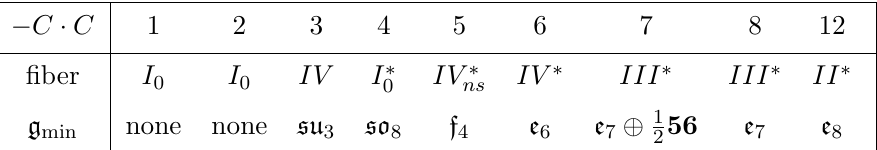
Table 1 . Minimal gauge groups for the 6d theories of rank 1. The (cid:12)rst two entries of the table correspond respectively to the E-string and to the